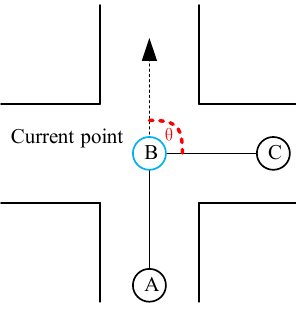
Figure 2. The point B’s turning angle θ . The points A, B, and C are GPS points recorded in time order.